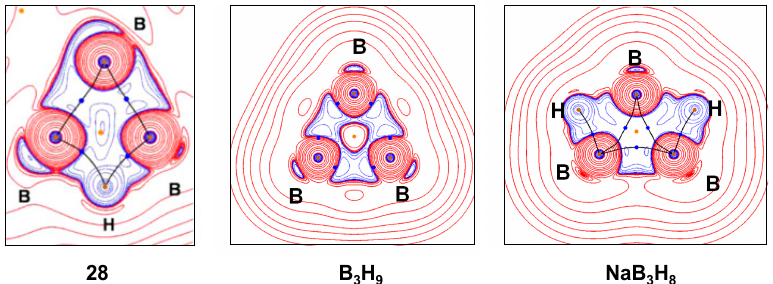
Figure 12. Laplacian contour map (– ∇ 2 ρ ) of the electron density in the B 3 plane of 28 (left), B 3 H 9 (middle), and NaB 3 H 8 . (right). Red and blue contour lines indicate areas of charge concentration ( ∇ 2 ρ < 0) and areas of charge depletion ( ∇ 2 ρ > 0), respectively. Reprinted and adapted with permission from Ref. [82]. Copyright (2015) American Chemical Society.